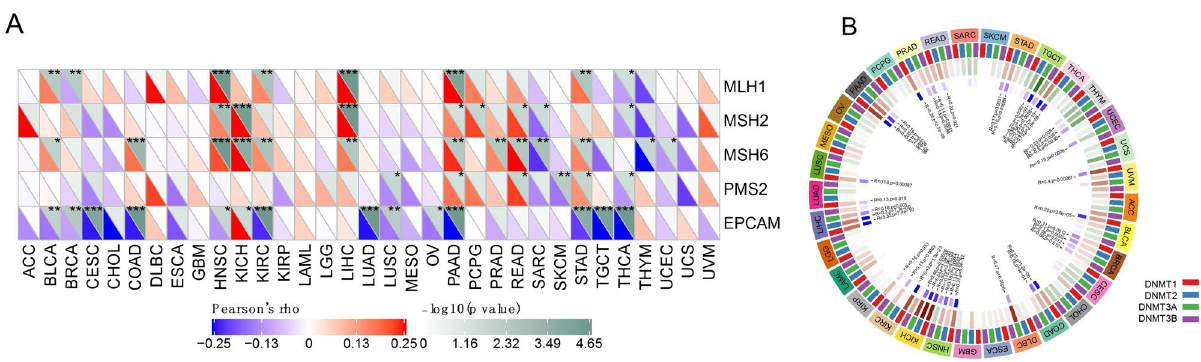
Figure 8. The correlations between TIGIT expression and five mismatch repair genes ( A ), as well as the correlations between TIGIT expression and DNA methyltransferase ( B ) across 33 cancer types. *p < 0.05, **p < 0.01, and ***p <